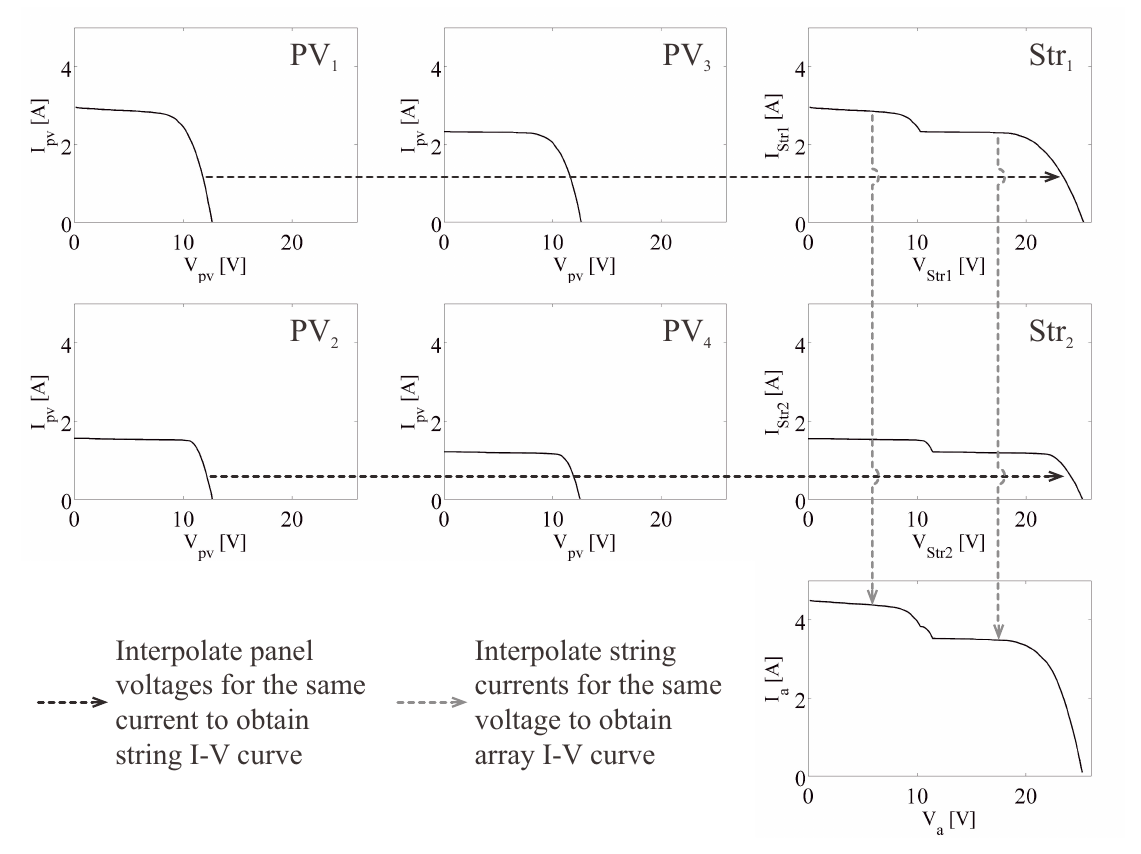
Figure 6. Example of the interpolation procedures to construct the I-V curve of one configuration for an SP array with two strings of two modules